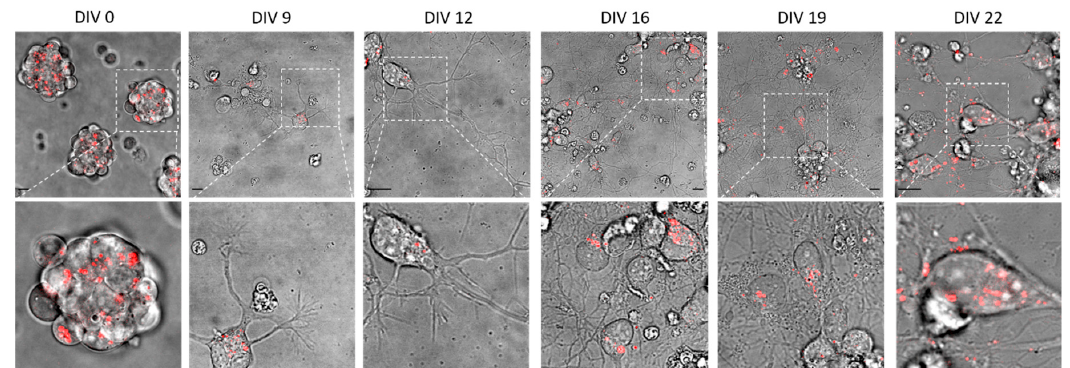
Figure 1. Microphotographs of living NSCs during differentiation, from DIV0 to DIV22. Bright-field microscopy images (top) with the respective magnification of the area selected by the dashed line (bottom). The bright field images are all superimposed to a confocal fluorescence microscopy image (a section within somas) of lysosomes labeled with LysoTracker Red (in red). Scale bars: 10 μ